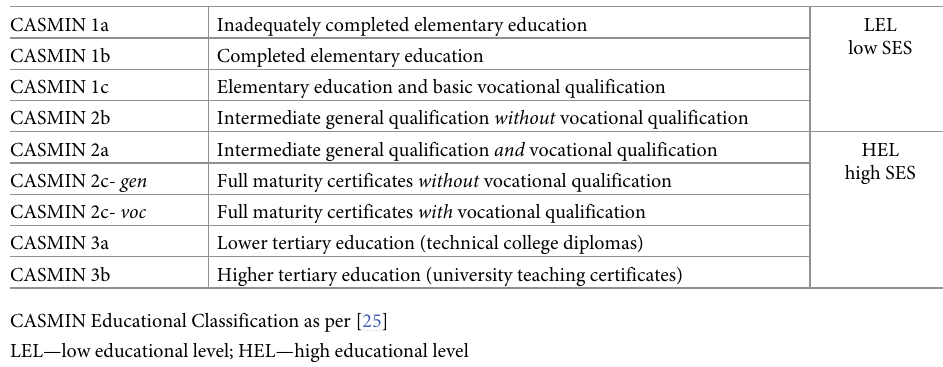
Table 1. CASMIN Educational Classification levels and modified allocation into two